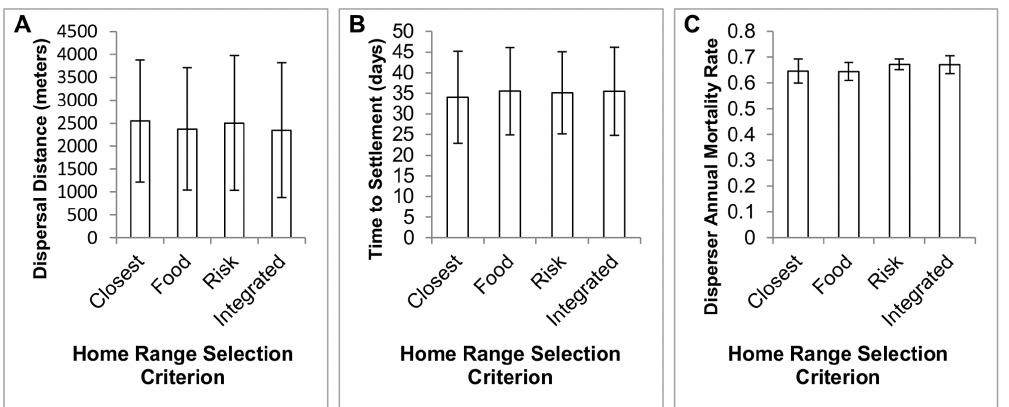
Figure 4. Effect of home range selection criterion on American martens. Mean( 6 1 SD) A) dispersal distance B) settlement time and C) annual mortality for virtual marten home range selection scenarios. Simulations consisted of martens that selected home range locations based upon proximity (closest), proximity and food availability (food), proximity and predation risk (risk), or proximity, predation risk and food availability